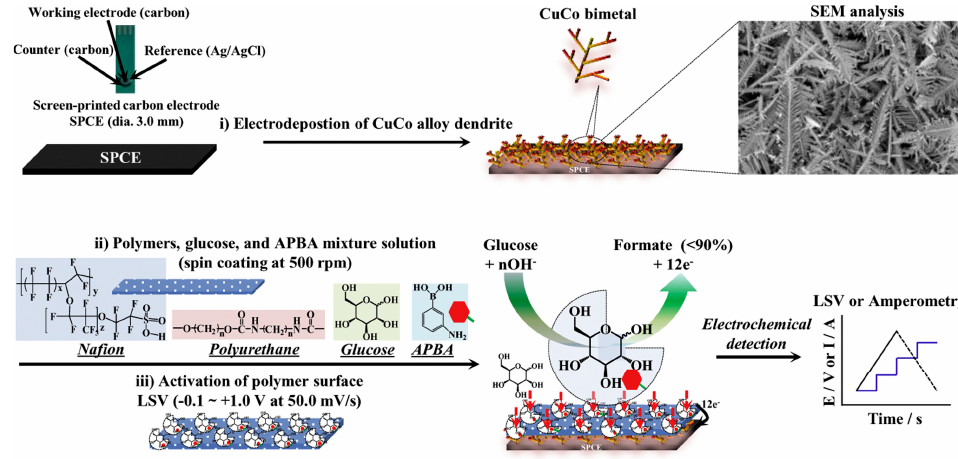
Figure 6. Representation of the glucose-imprinted polymer preparation and the two electrochemical readouts employed for the rebinding studies. Figure reproduced with permission from ref. [105]. Copyright 2018, Elsevier.